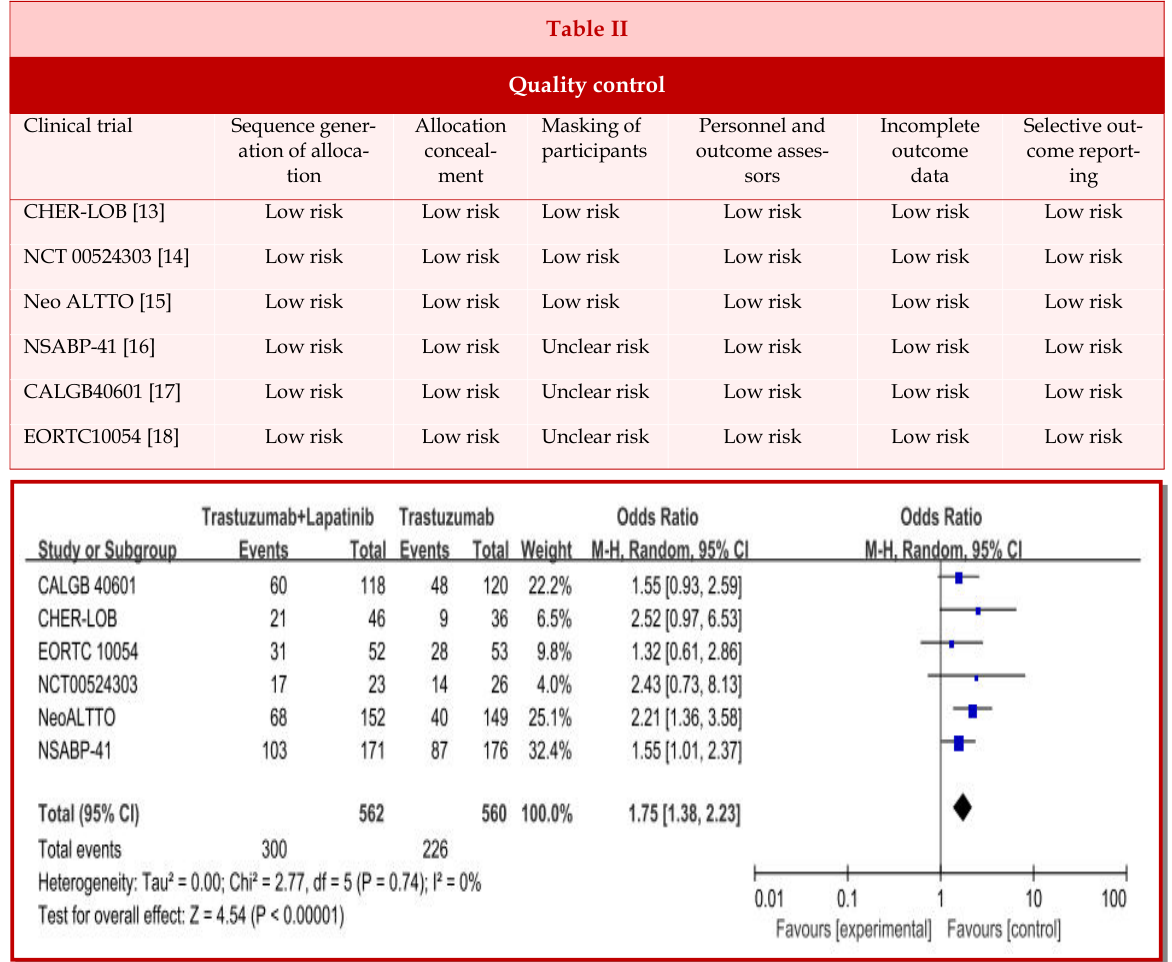
Figure 2: The results of